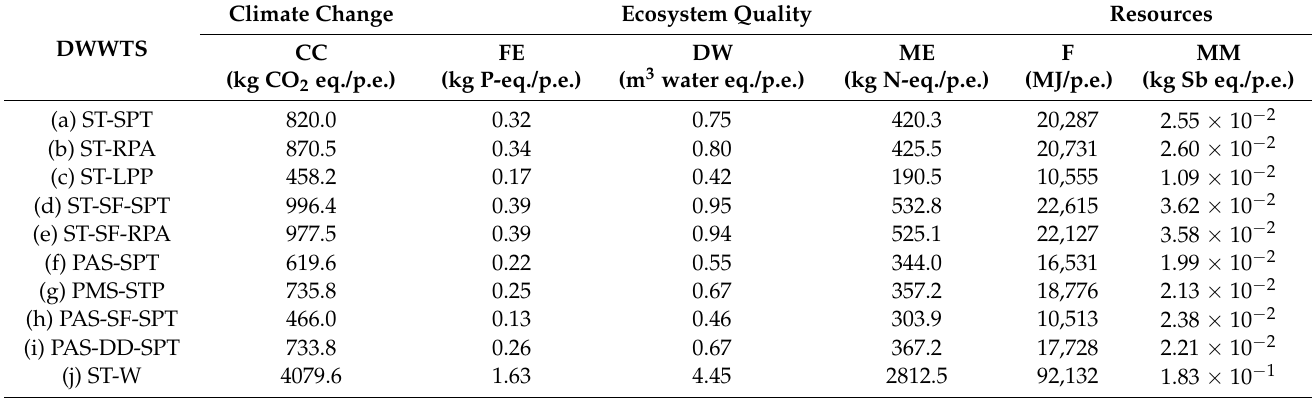
Table A4. Embodied environmental burdens per population equivalent (p.e.) for each DWTTS. Climate Change Ecosystem Quality Resources DWWTS